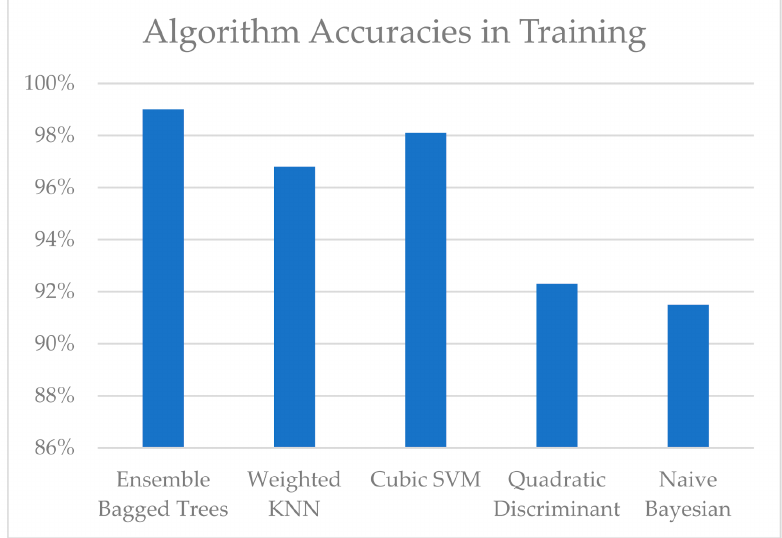
Figure 10. Accuracy results for different algorithms for the synthetic